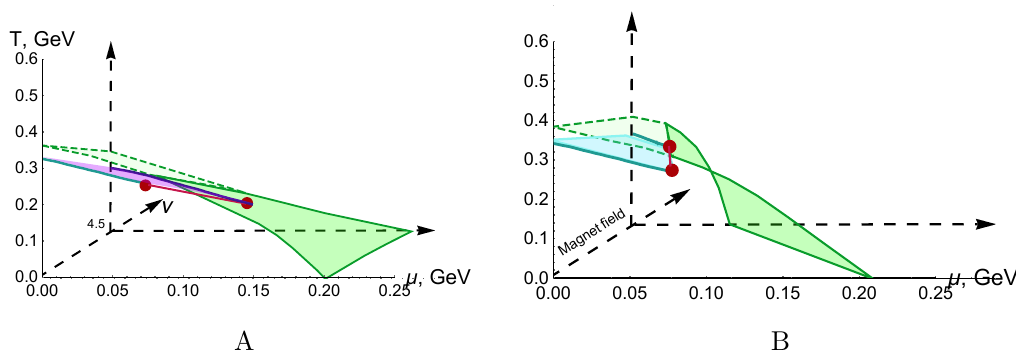
Figure 18 . Schematic representations of the structure of phase transitions of a model describing heavy quarks depending on the anisotropy caused by: parameter ν (A), magnetic field (B). first-order phase transition line elongates. In the figure 18 B, we see qualitatively the same situation with increasing magnetic field, the phase transition occurs at lower temperature values for the same chemical potential values, but the first-order phase transition line